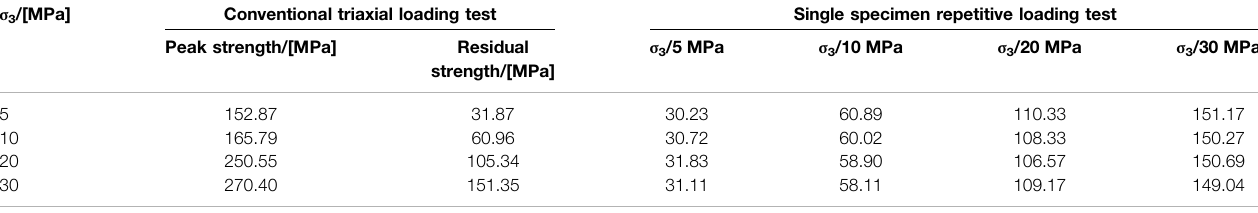
TABLE 1 | Comparison of the results of conventional triaxial loading and single specimen repeated loading tests. σ 3 /[MPa]